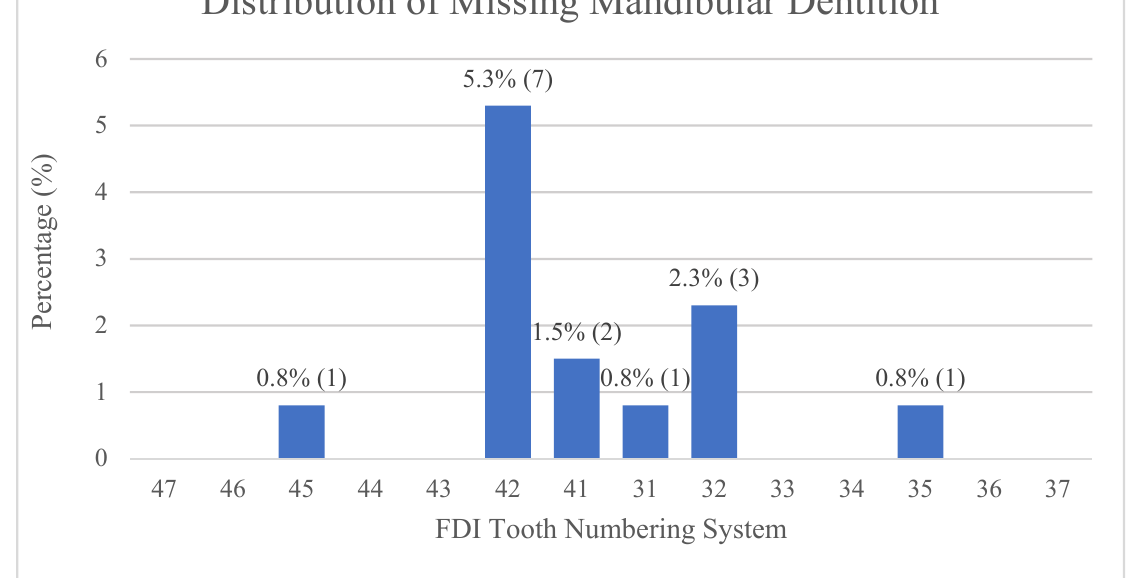
Figure 1. The distribution and frequency of missing teeth. * (1) Tooth numbering is according to the Fédération Dentaire Internationale (FDI) tooth numbering system for maxillary and mandibular dentition. (2) Percentage of missing teeth (missing number of each tooth site/total patient number (132)). (3) Numbers of missing teeth for each tooth site are listed in the parentheses. (4) The third molars are not examined in this study.